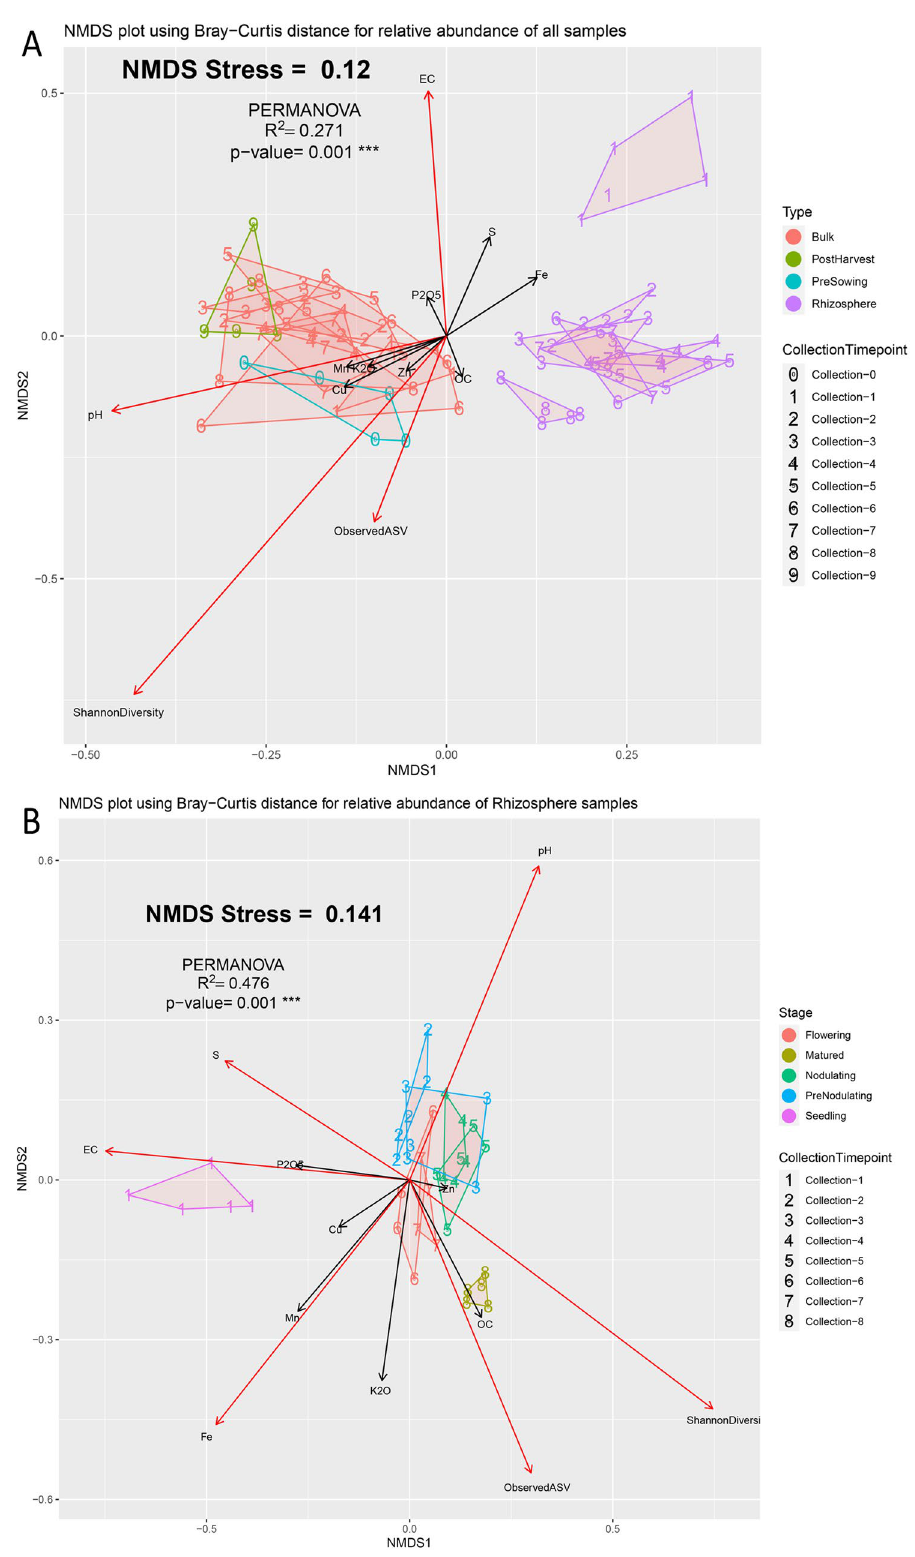
Figure 3. NMDS plot of Bray–Curtis distance calculated from ( A ) all samples and ( B ) Rhizosphere samples only. Collection number of each sample is used as shape to denote the sample. Environment fit vectors representing physical parameters and nutrient concentrations are shown as arrows. Vectors with significant associations are shown in red coloured